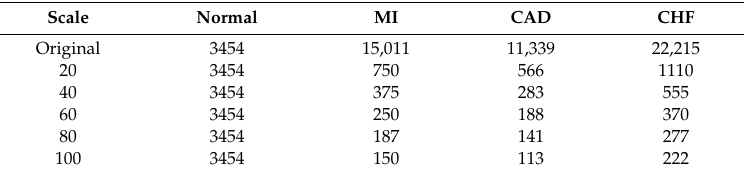
Table 12. The number of instances of each category in di ff erent